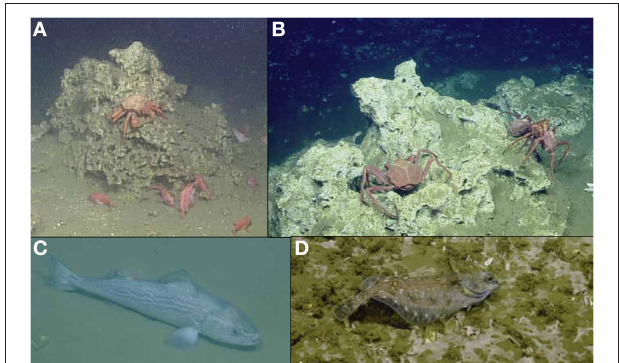
FIGURE 2 | Seep habitat use by “background” species of commercial value: (A) California King crab and thornyheads (B) Lithodid crabs (C) sablefish ( Anoplopoma fimbria ) and (D) Pacific Dover Sole ( Microstomus pacificus